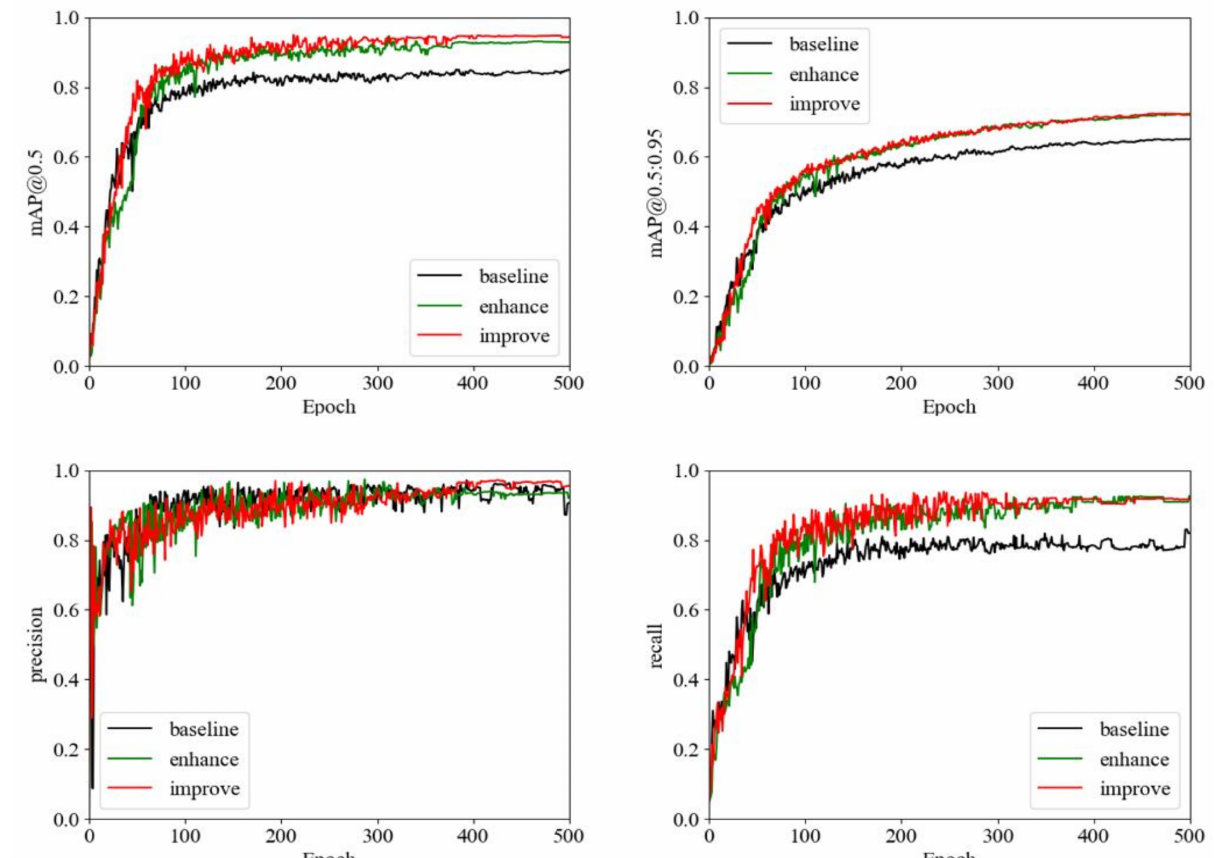
Figure 7. Comparison chart of training curve